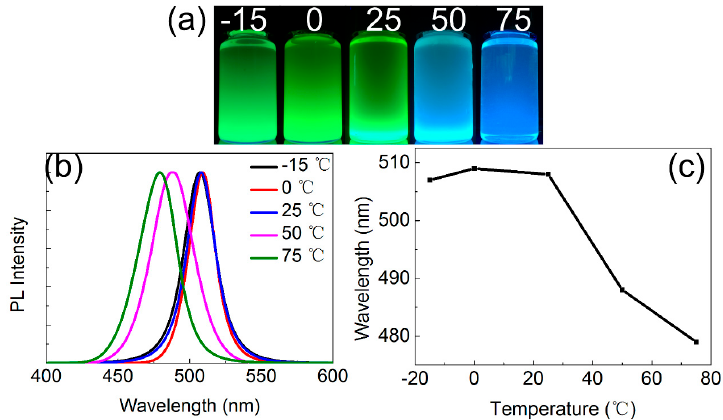
Figure A6. ( a ) Digital images under the UV light of 365 nm; ( b ) emission spectra; and ( c ) wavelength statistical chart of QDs-M with different reaction temperature, where chloroform is used as nonpolar solvent.